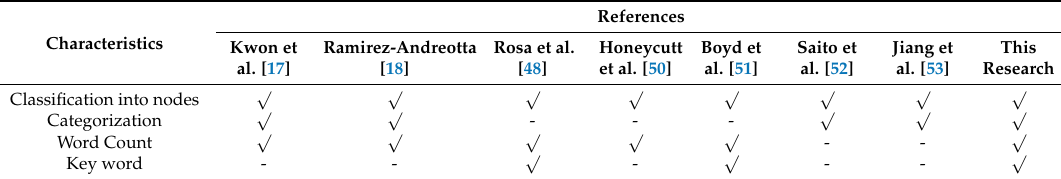
Table 5. Characteristics of textual analysis in